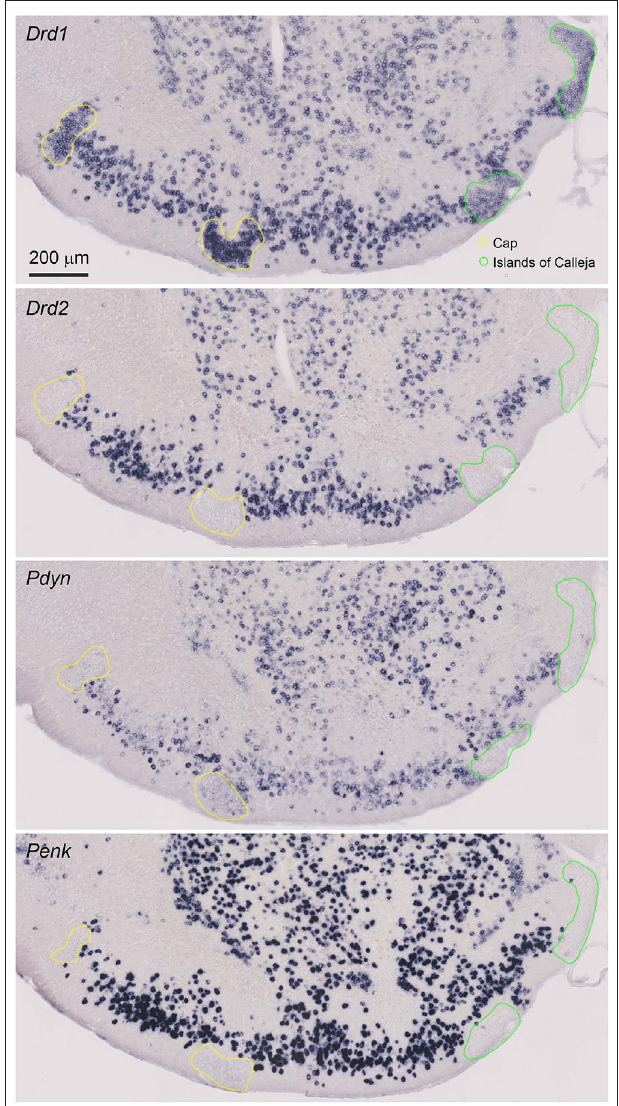
FIGURE 2 | Magnified view of the single probe ISH for Drd1, Drd2, Pdyn, and Penk in the anterior OT. Pictures show coronal sections of the anterior OT (approximately at Bregma + 1.70mm). In the OT, ISH signals of Pdyn and Penk were observed in the DCL. Regions delineated by yellow lines are the Cap regions. Regions delineated by green lines are the ICj. Adjacent sections from one mouse were used for the four pictures. Brain sections in this figure were sampled from a different mouse used in Figure 1